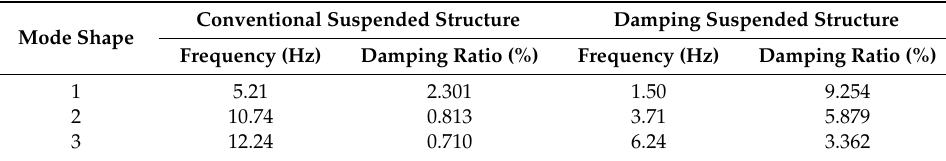
Table 5. Frequency and damping ratio of